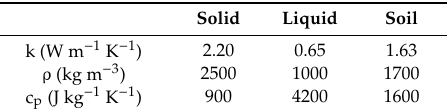
Table 2. Thermal properties of the soil.